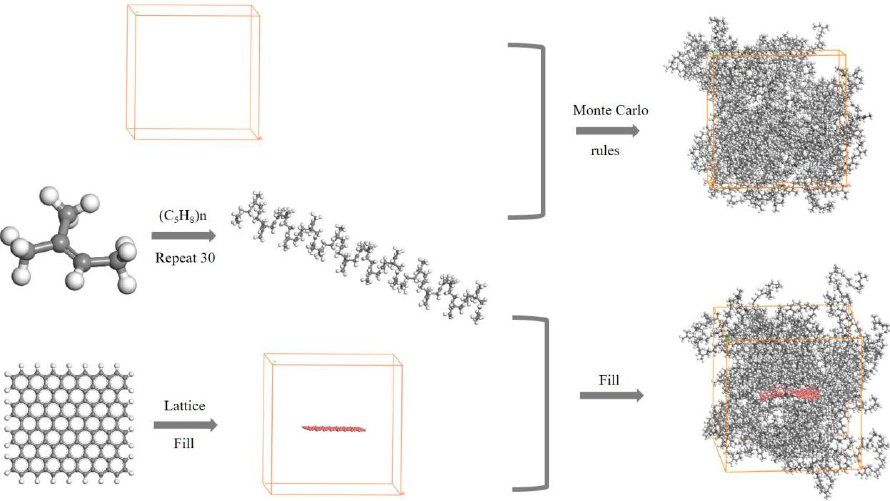
Figure 2. Molecular model: NR amorphous molecular model and GNS/NR amorphous molecular model.